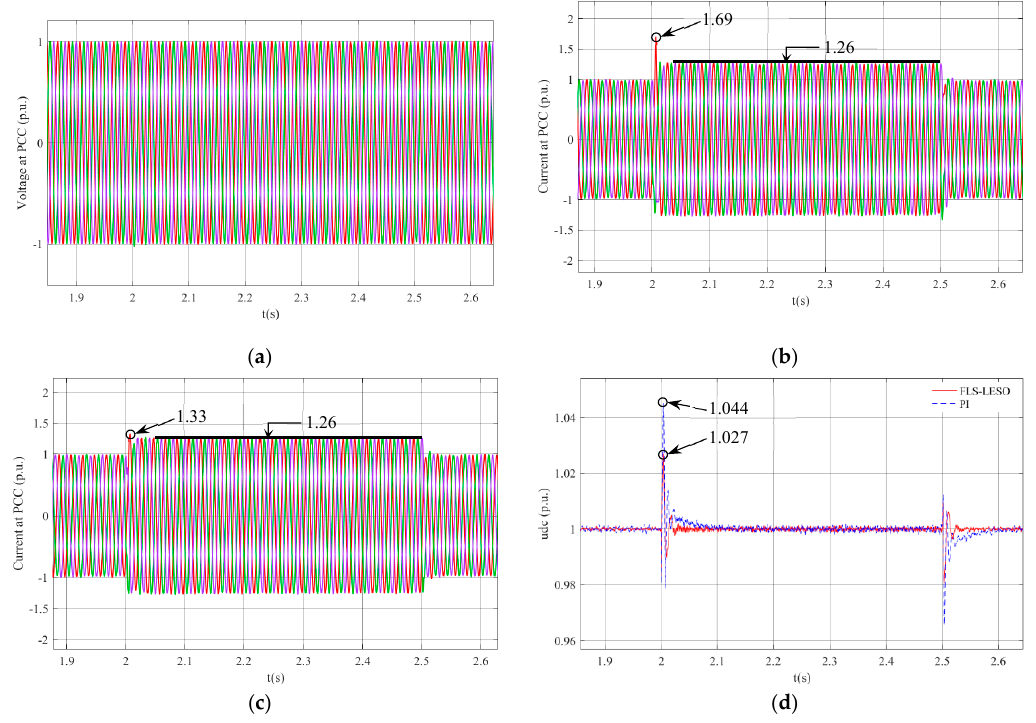
Figure 14. ( a – d ). Dynamic response of a 1.5 MW permanent magnet synchronous generator (PMSG) with the traditional PI controller and fuzzy logic system with linear extended state observer (FLS-LESO) during the 30% increase in wind turbine power; ( a ) Voltage at PCC; ( b ) Current at PCC with the PI controller; ( c ) Current at PCC with the FLS-LESO; ( d ) DC link voltage.